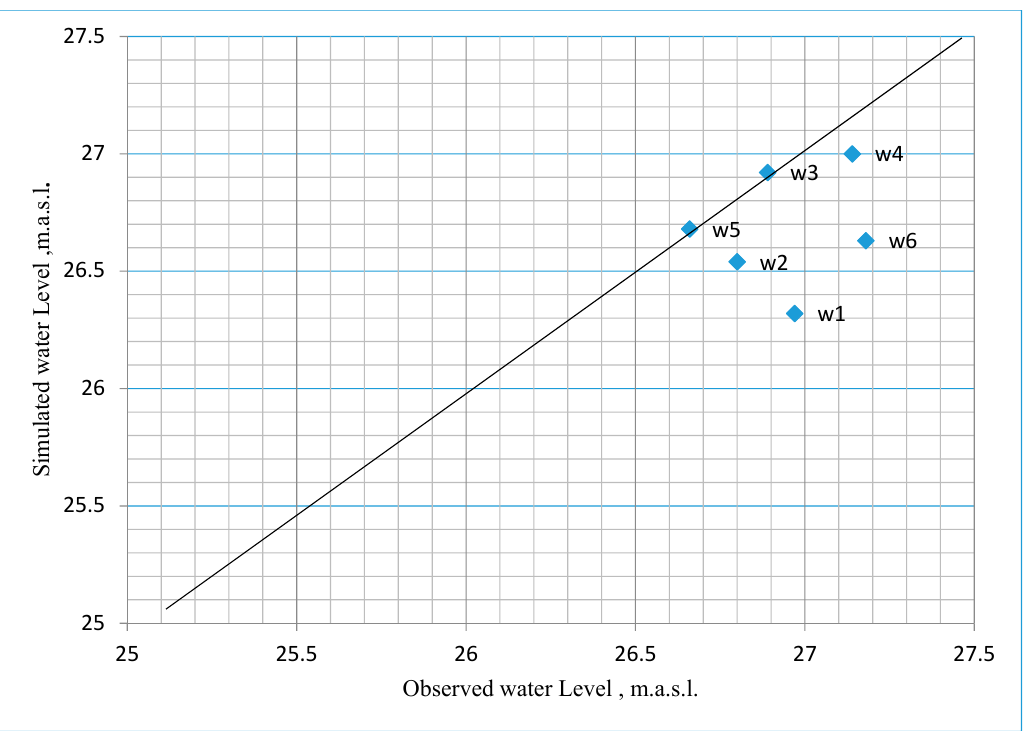
Figure 8. Comparison of simulated and observed heads for minimum water surface elevation of Tigris River (27.60 m.a.s.l.), Scenario 2.